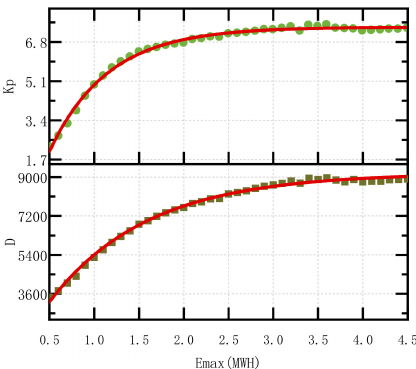
Figure 10. The relationship between K p , D , and energy of ESS.